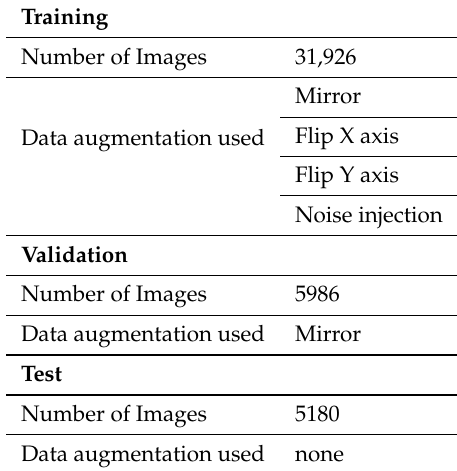
Table 1. TH30 dataset